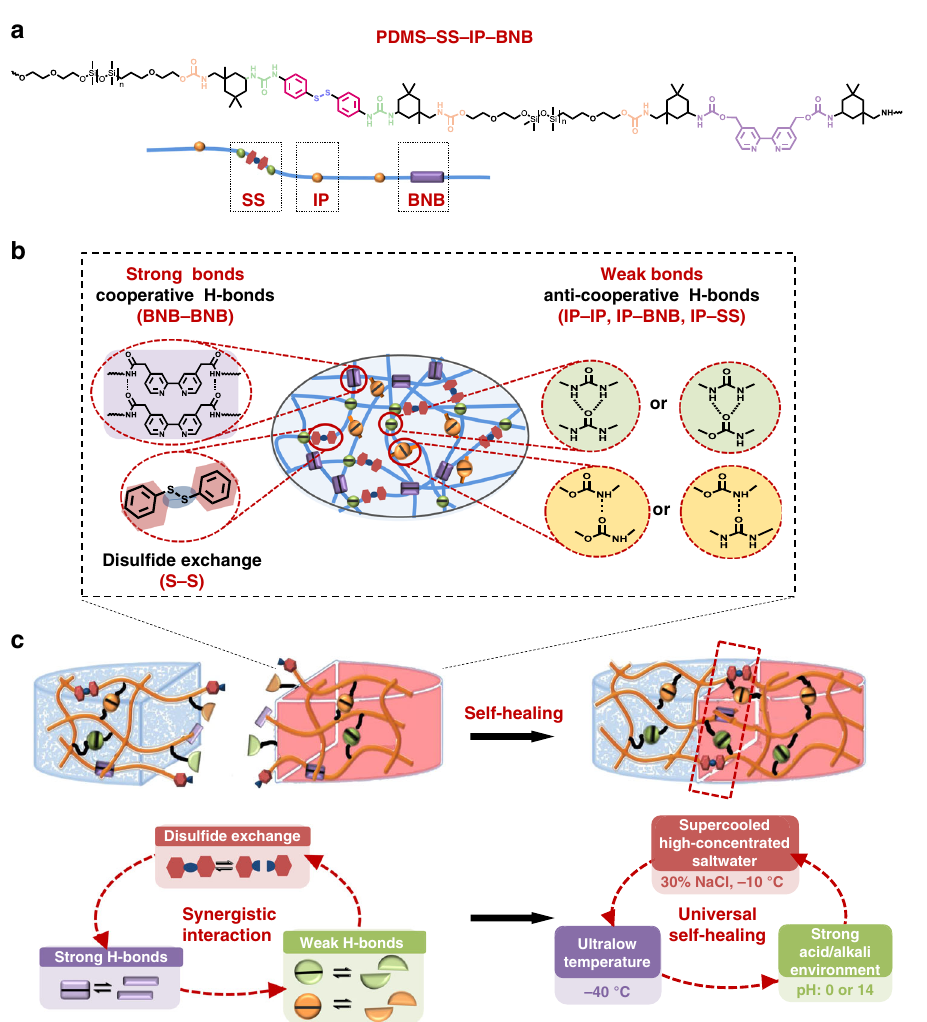
Fig. 1 Molecular design of the PDMS – SS – IP – BNB elastomer with high toughness, stretchability, and universally autonomous self-healing ability. a Chemical structure of PDMS – SS – IP – BNB. b The proposed ideal structure of the supramolecular polymer network based on strong crosslinking H-bonds (BNB – BNB), weak crosslinking H-bonds (IP – IP, IP – BNB, IP – SS), and disul fi de metathesis (S – S). c The synergistic interaction of multiple dynamic bonds contributes to universally self-healing capability of